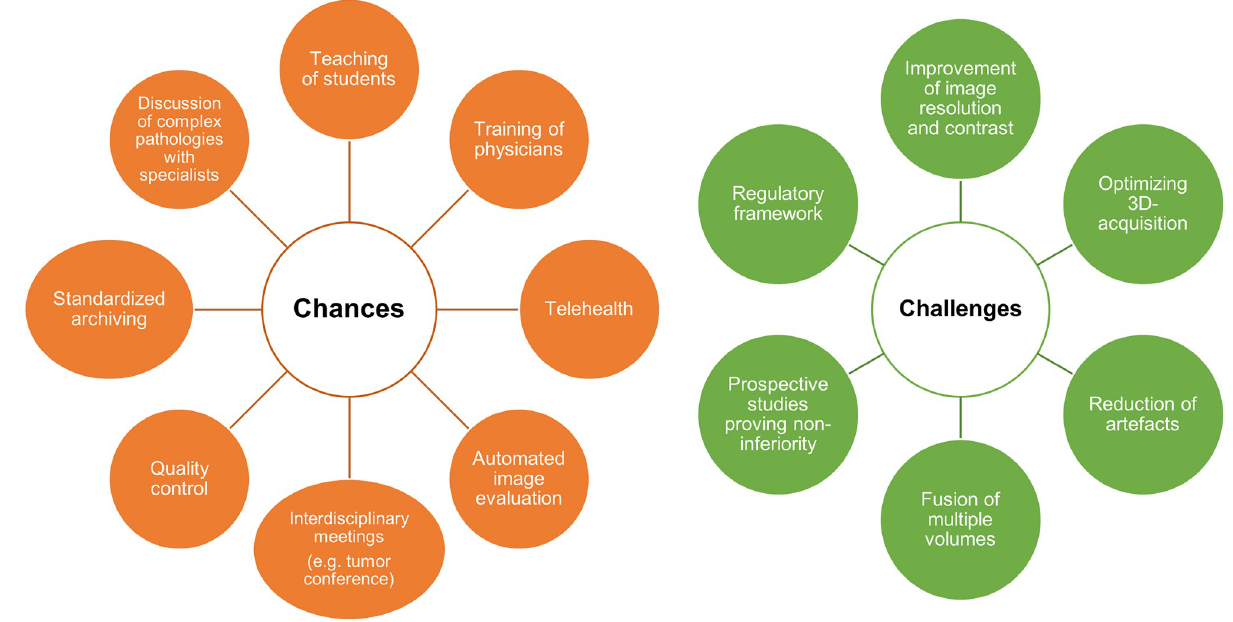
Fig 4. Chances and challenges of three-dimensional ultrasound